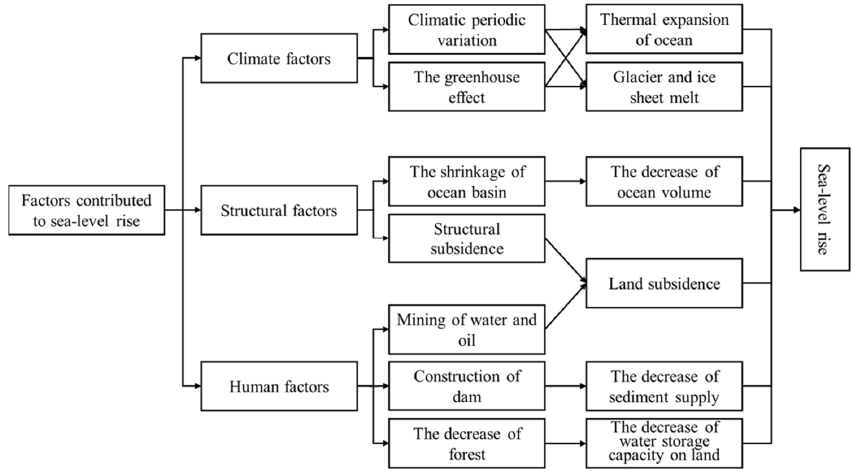
Figure 4. Factors affecting sea ‐ level rise and their mechanisms.